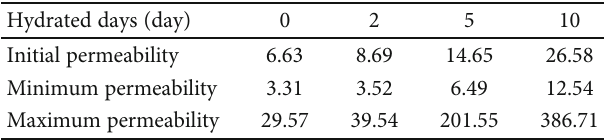
Figure 3: The curves of stress and permeability variation. Table 2: The permeability considering hydraulic pressure with di ff erent con fi ning pressures (10 -18 m 2